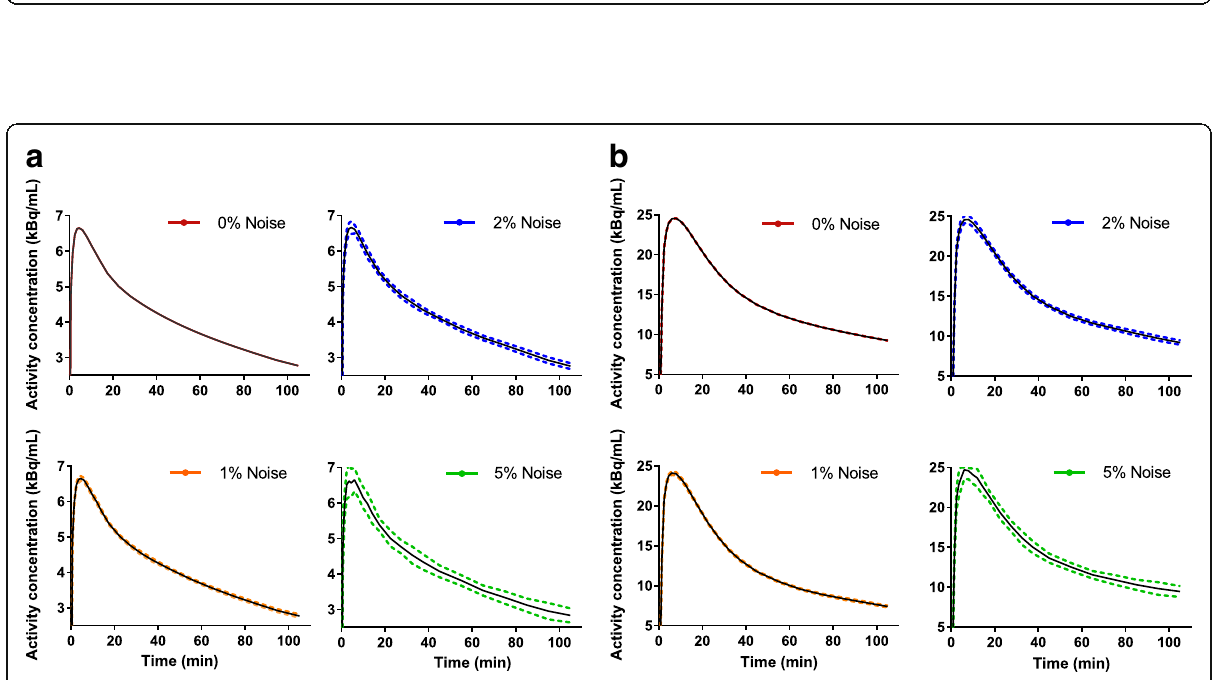
Fig. 2 SRTM simulated target tissue TACs for the range of BP sim and b [ 18 F]florbetaben